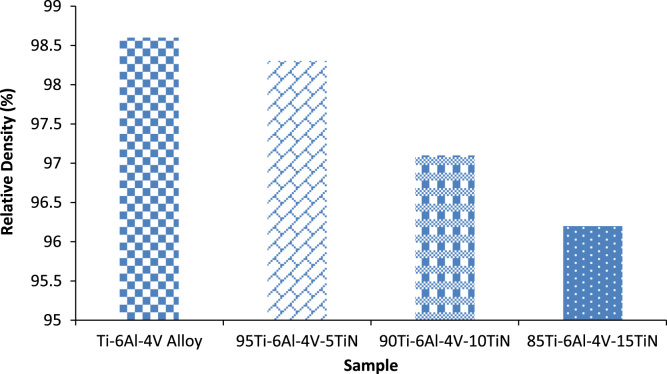
Relative densities of the sintered compacts of Ti–6Al–4V and developed Ti–6Al–4V–xTiN.